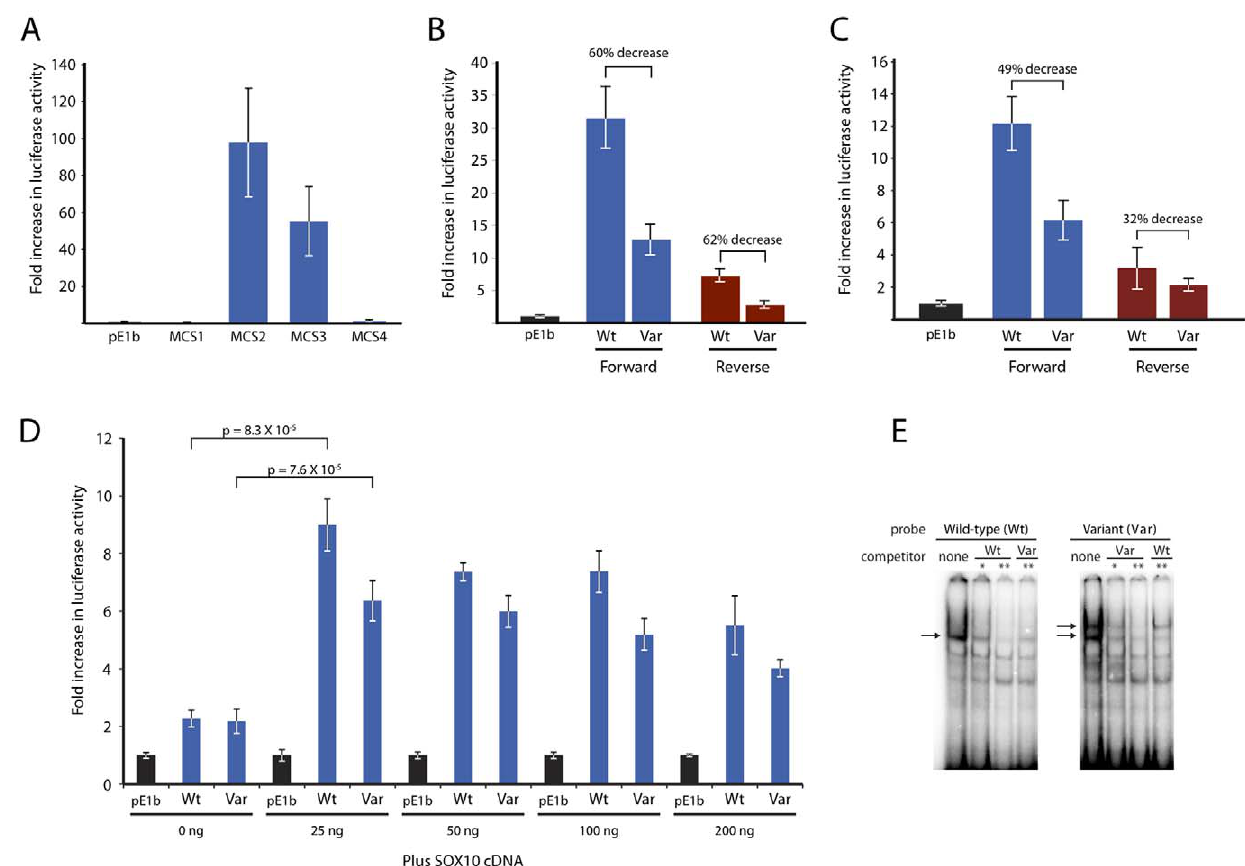
Figure 2. Functional characterization of the c.126-1086T . A variant in MPZ -MCS3. ( A ) Genomic segments spanning each MPZ MCS ( MPZ - MCS1, MPZ -MCS2, MPZ -MCS3, and MPZ -MCS4) were tested for their ability to direct luciferase reporter-gene expression in cultured Schwann (S16) cells compared to a control vector (pE1b). Error bars indicate standarddeviation. ( B ) Wild-type (Wt) andc.126-1086T . A variant (Var) formsof MPZ -MCS3 were tested for their ability to direct luciferase reporter-gene expression in the forward (blue) and reverse (red) orientations in cultured Schwann (S16) cells compared to a control vector (pE1b). Error bars indicate standard deviation. ( C ) Similar experiments as described in B were performed with cultured oligodendrocytes (OliNeu) cells. ( D ) Wild-type (Wt) and c.126-1086T . A (Var) forms of MPZ -MCS3 were tested for their responsiveness to SOX10 via luciferase reporter-gene expression in SOX10-negative MN1 cells, in the forward orientation compared to a control vector (pE1b). The amount of SOX10 expression vector co-transfected is shown. Error bars indicate standard deviation and p-values were calculated using the student’s t-test. ( E ) Electrophoretic mobility shift analysis (EMSA) of wild-type and c.126-1086T . A alleles. ‘Probes’ (radiolabeled oligonucleotides) and ‘competitors’ (unlabeled oligonucleotides) corresponding to a 25-bp fragment including the wild-type (Wt) and c.126-1086T . A variant-containing (Var) consensus SOX10-binding sequence in MPZ -MCS3 (see Fig. 1B) were incubated with S16 nuclear extracts and subjected to electrophoresis (see Materials and Methods). Each assay used the same amount of probe coupled with varying amounts of competitor, as shown (‘none’ indicates no competitor; * and ** indicate a probe to competitor ratio of 1:10 and 1:100, respectively). Arrows denote specific nuclear proteins bound to the probe.